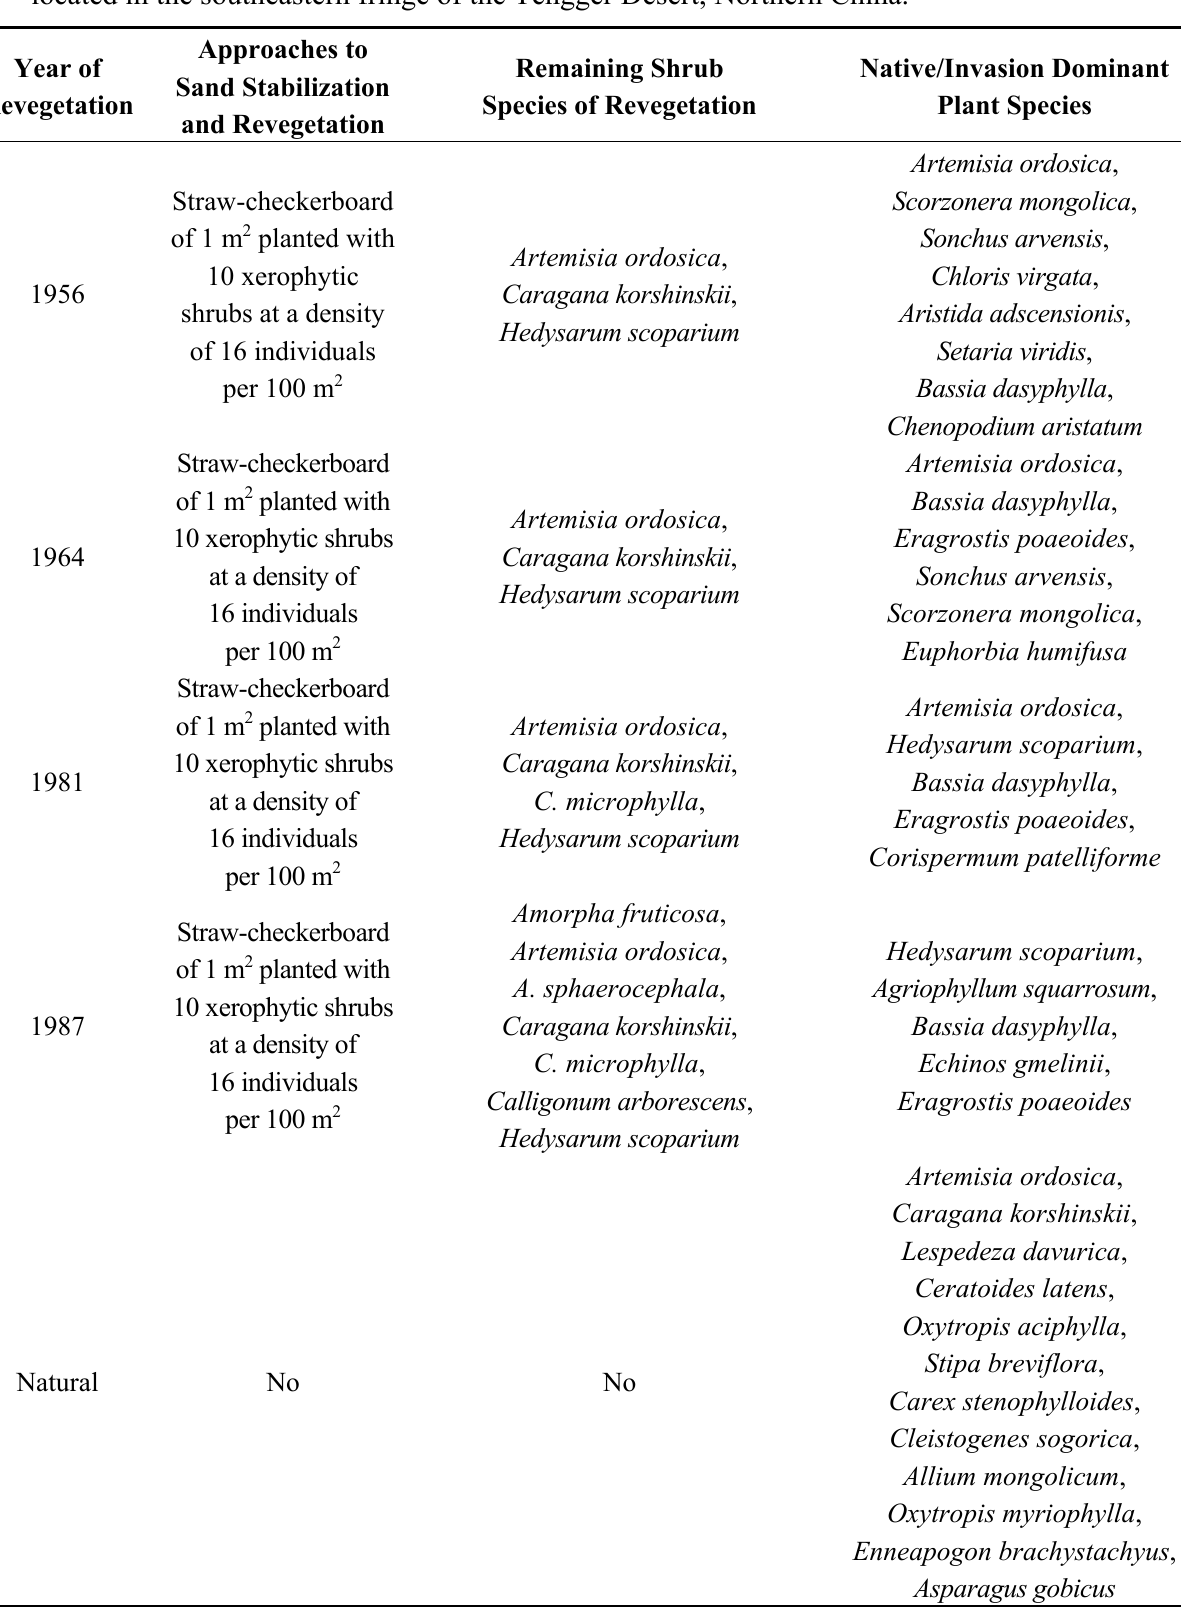
Table 1. Description of four revegetation sites with different ages and a natural community located in the southeastern fringe of the Tengger Desert, Northern